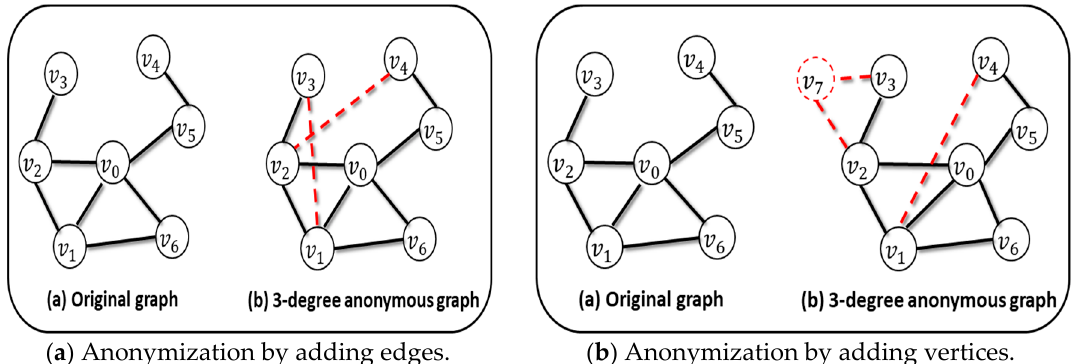
Figure 41. An example of the SN users graph anonymization by adding edges and vertices.